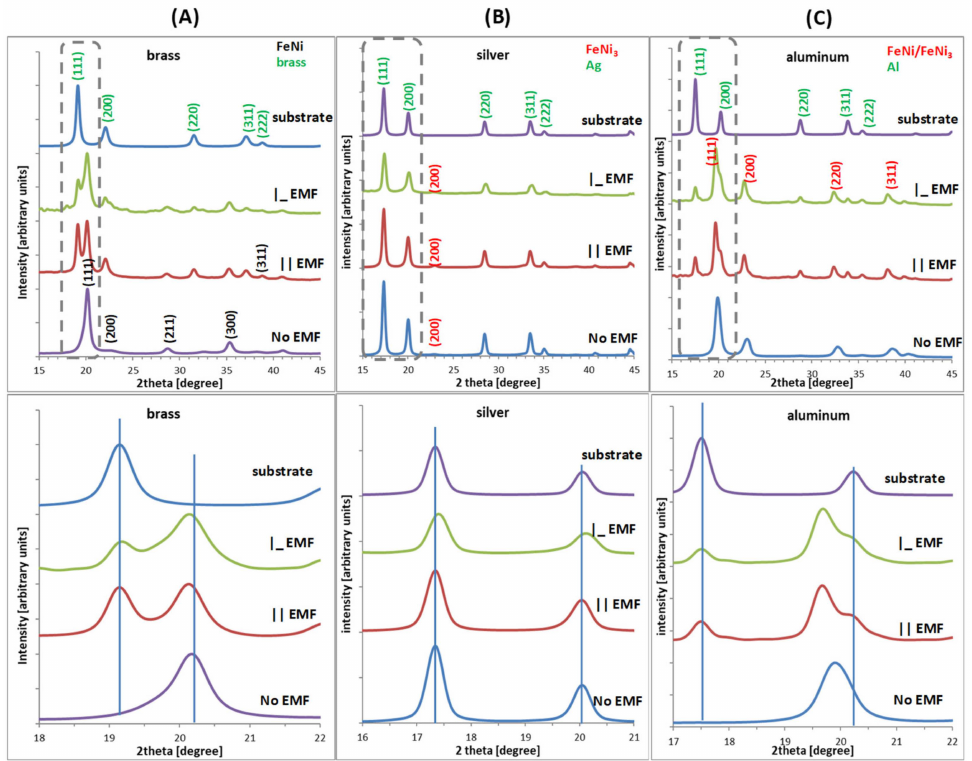
Figure 6. Diffraction XRD patterns of FeNi electrodeposited films divided for different substrates: ( A ) brass, ( B ) silver, and ( C ) aluminium, time of deposition—3600